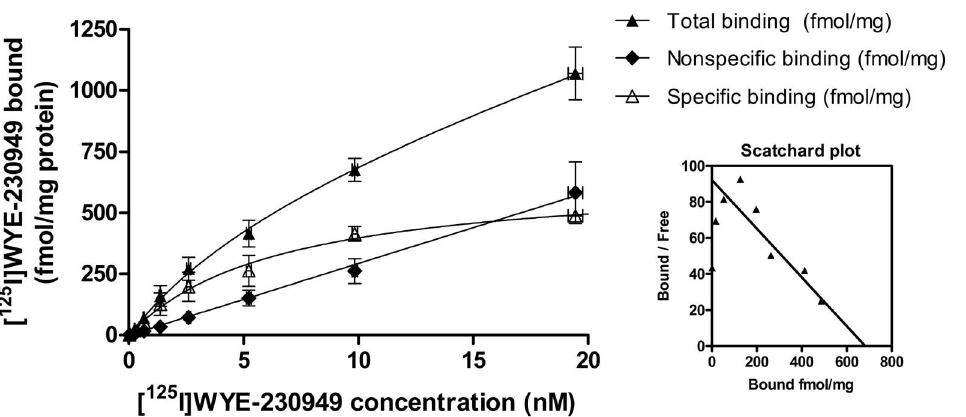
Fig. 2. Representative saturation binding curve for [ 125 I]WYE-230949. Total, non-specific and specific binding to rat brain homogenates are plotted with the corresponding Scatchard